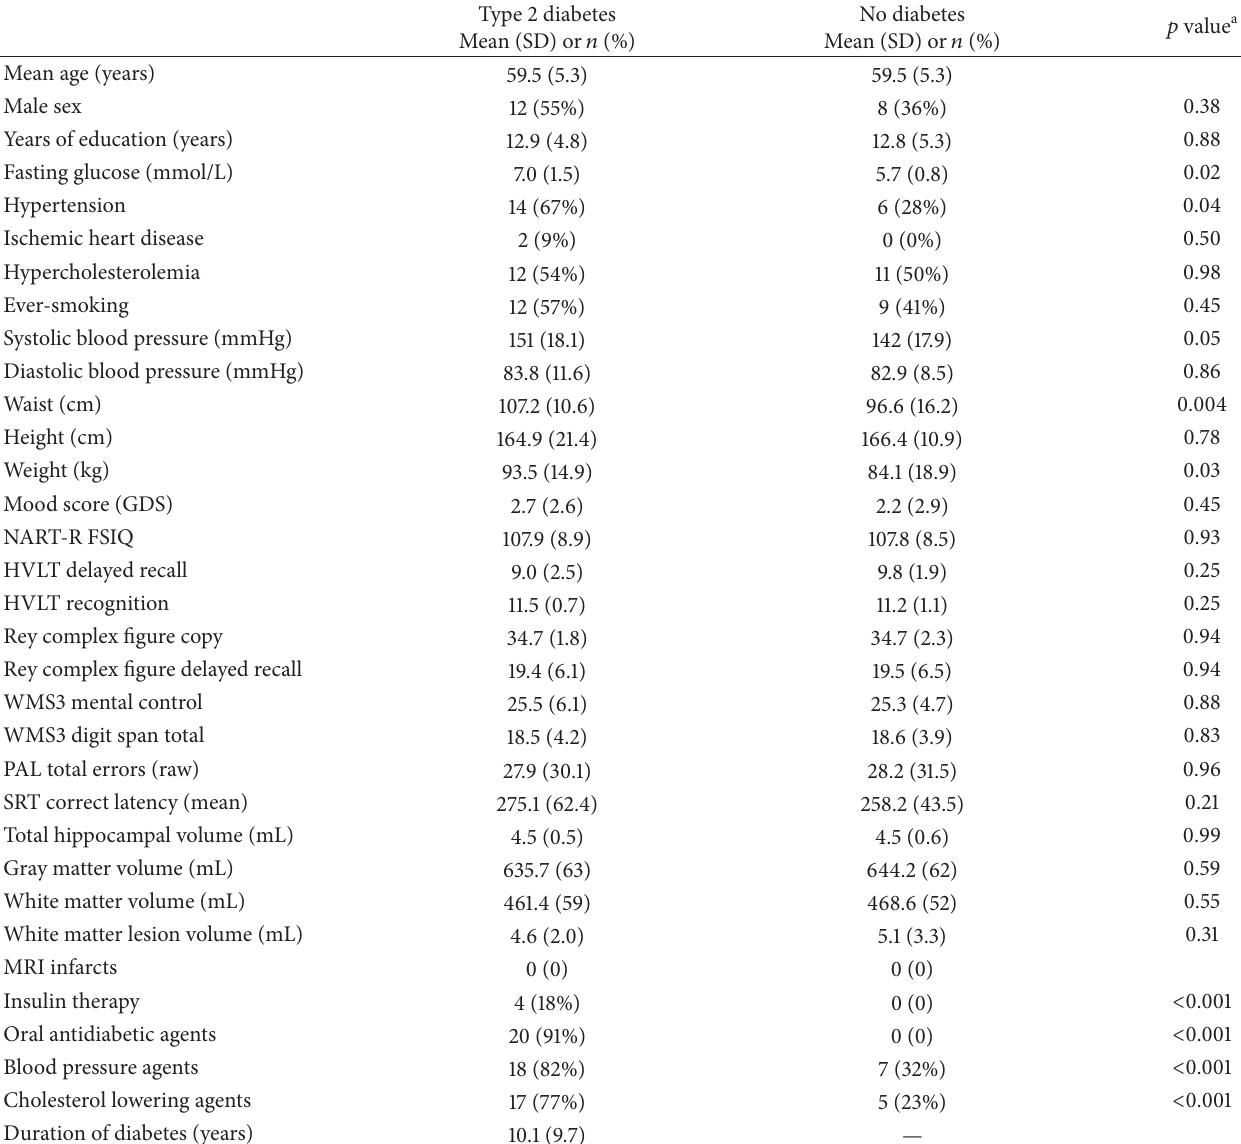
Table 1: Sample characteristics (22 discordant twin